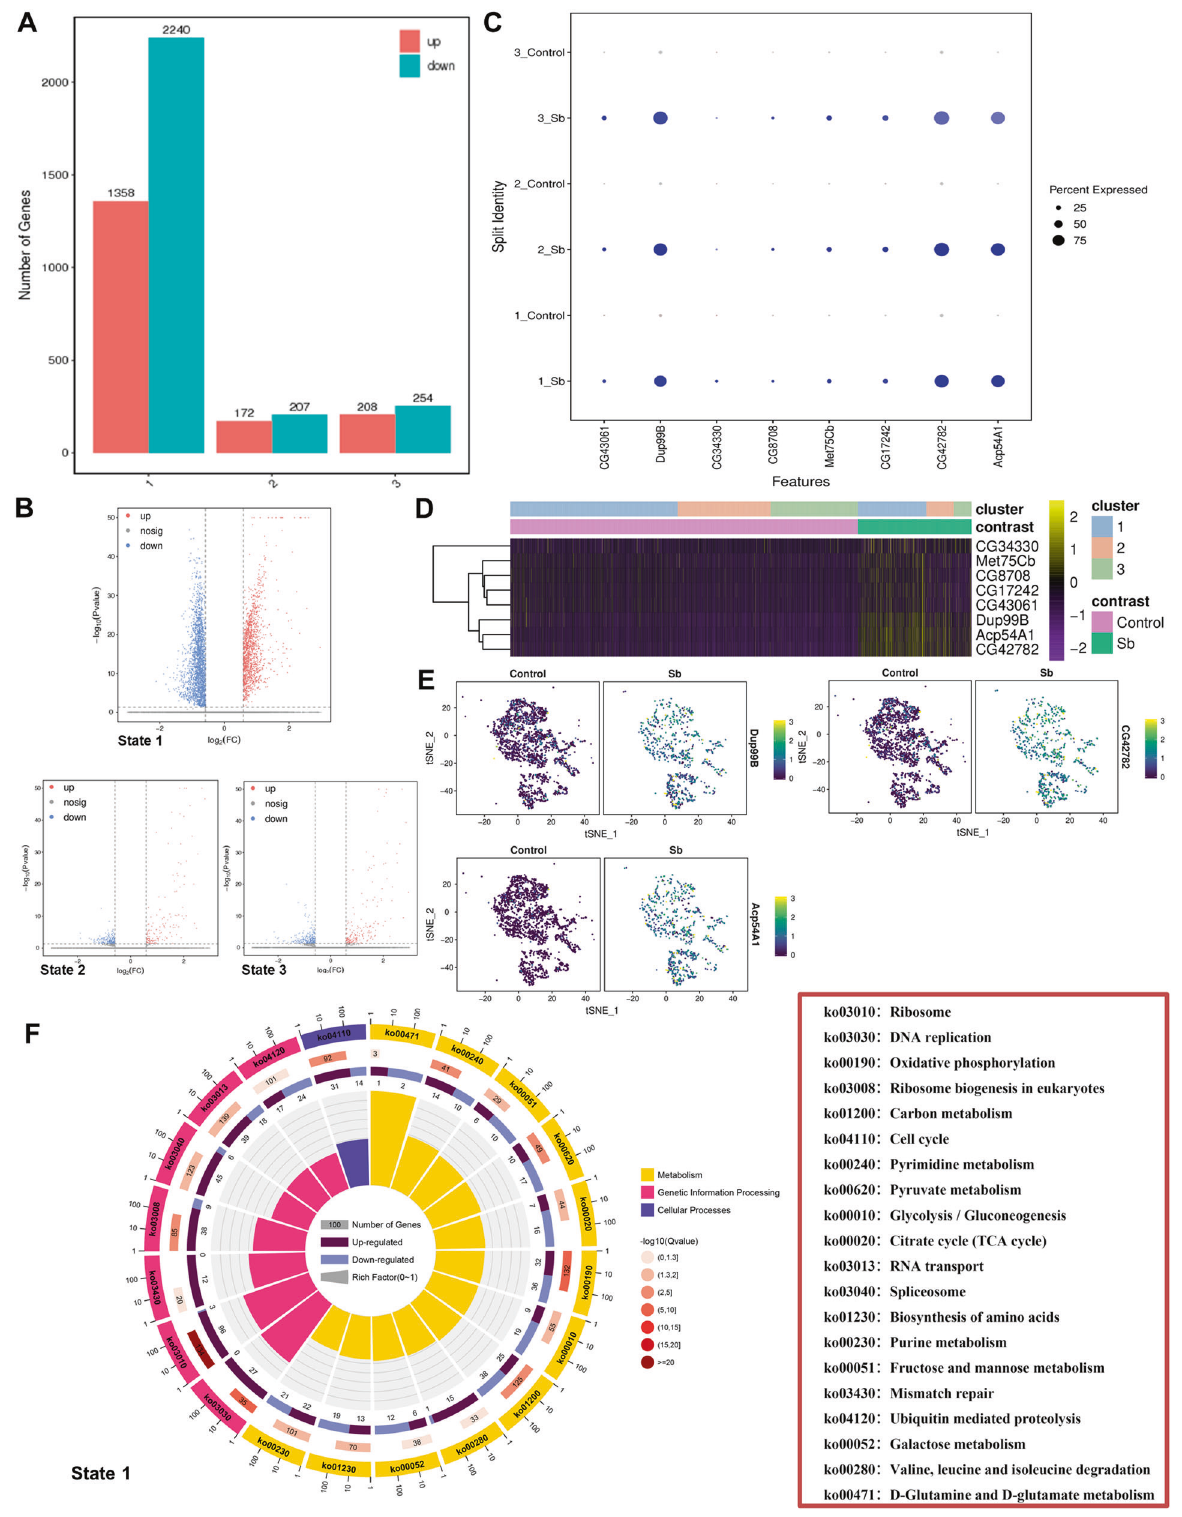
Fig. 8 Analysis of Sb exposure mediated DEGs in three novel states of germ cell populations. A The number of DEGs in three states of germ cell populations between control and Sb groups. B The volcano plot views of DEGs in three states between two groups. C The dot plot view of representative enriched genes which are upregulated in all three states of germ cell populations. D The heatmap view of representative enriched genes in three states of germ cell populations. E tSNE visualizations of Dup99B , CG42782 and Acp54A1 genes in control and Sb groups. F The KEGG analysis for DEGs in state 1 germ cell populations.